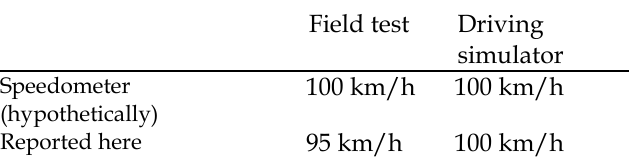
Table 5. Example of potential differences between speedometer and reported